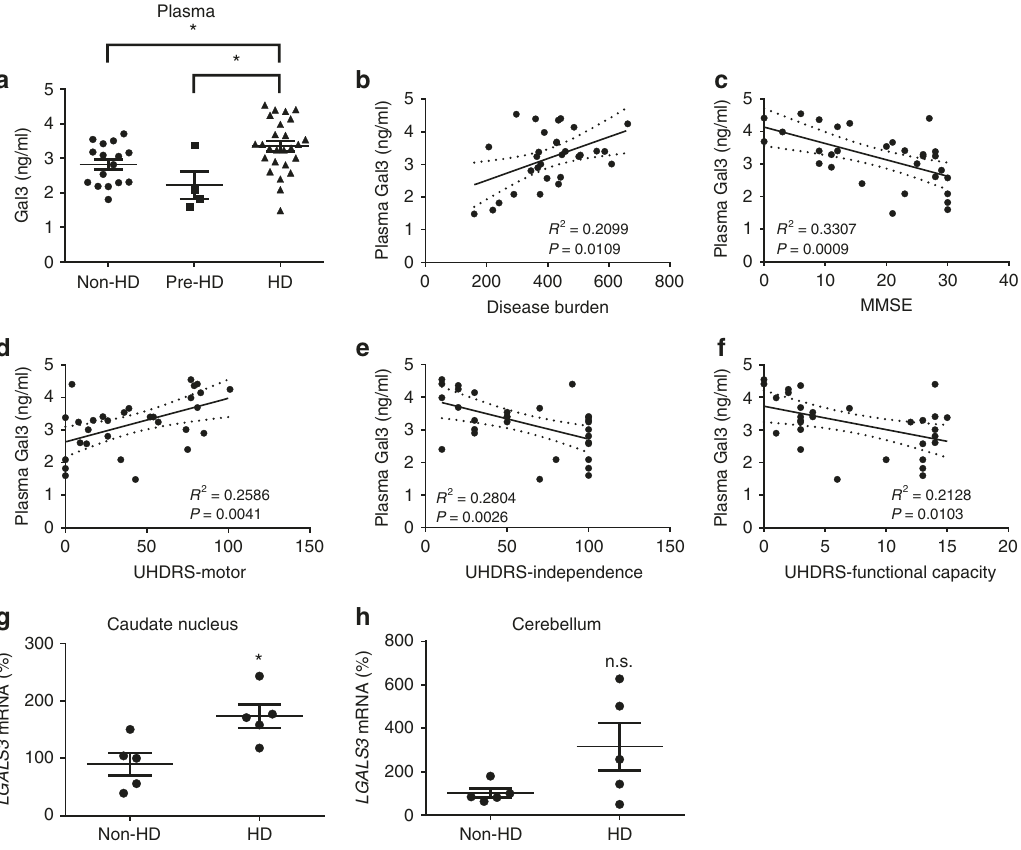
Fig. 1 Up-regulation of Gal3 in the plasma and brains of HD patients. a The levels of plasma Gal3 of non-HD ( n = 16), pre-symptomatic HD (Pre-HD, n = 4), and HD individuals ( n = 26) were measured by ELISA. b – f Correlations between the plasma Gal3 levels of HD patients ( n = 26) and their disease burden b , MMSE c , UHDRS-motor d , UHDRS-Independence e , or UHDRS-functional capacity f scores were analyzed by Pearson correlation coef fi cients. The levels of transcripts of LGALS3 in the g caudate nucleus and h cerebellum of HD patients or non-HD subjects were measured by RT-qPCR ( n = 5 in each group). Each dot represents the plasma Gal3 level or the relative LGALS3 level of a subject. Data in ( a ) were analyzed by one-way ANOVA followed by Holm – Sidak ’ s multiple comparisons test, * P < 0.05. Data in g and h are presented as the means ± SEM and were analyzed by the unpaired Student ’ s t -test. * P < 0.05. n.s., not signi fi cant. Source data is available as a Source Data